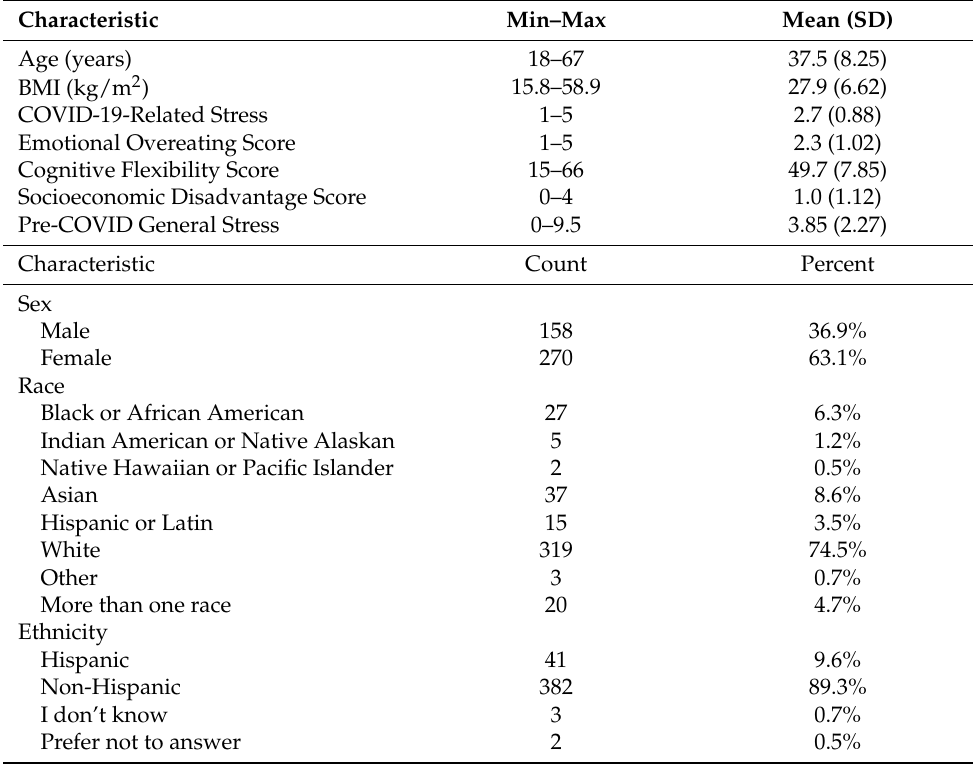
Table 1. Participant demographic characteristics ( n =